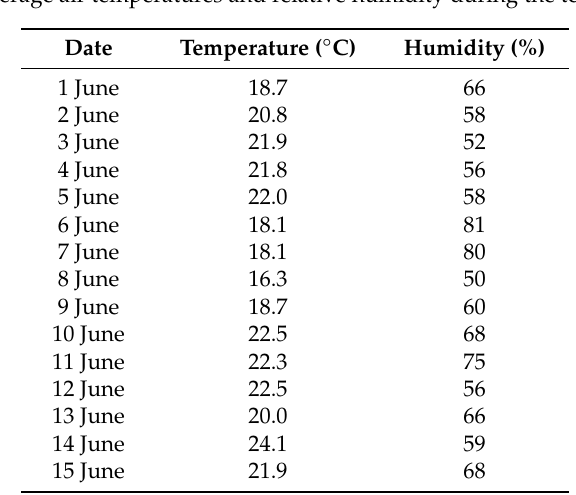
Table 3. Average air temperatures and relative humidity during the testing